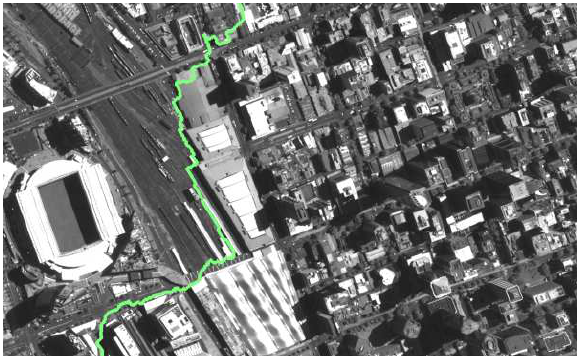
Figure 6. Stiching line : Melbourne stadium